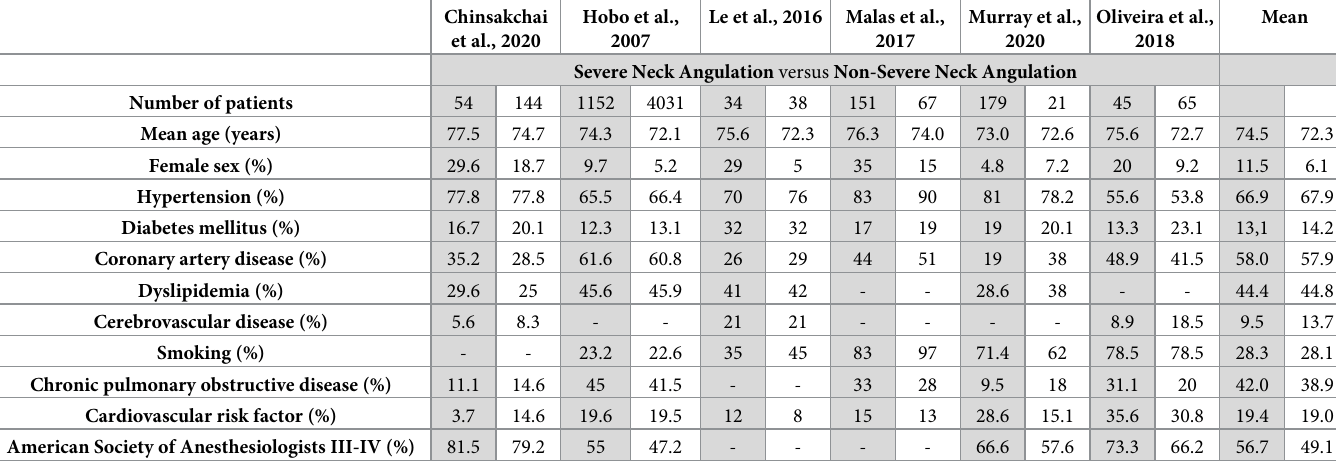
Table 2. Demographics and